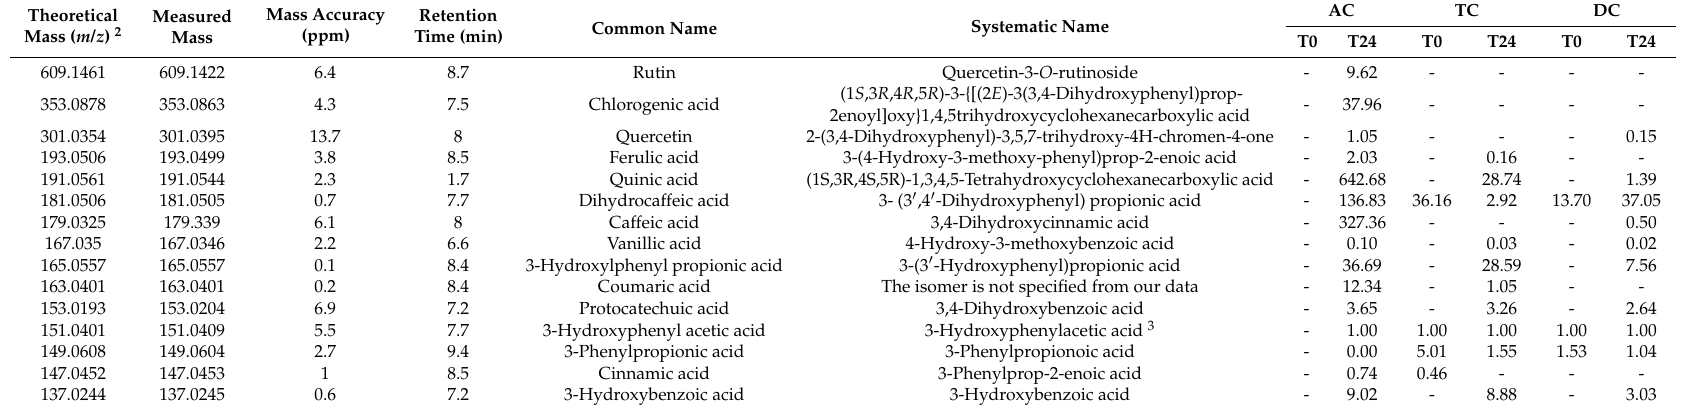
Table 1. Polyphenols and their metabolites after human-stimulated intestinal digestion at baseline (T0) and after 24 h (T24) postdigestion 1